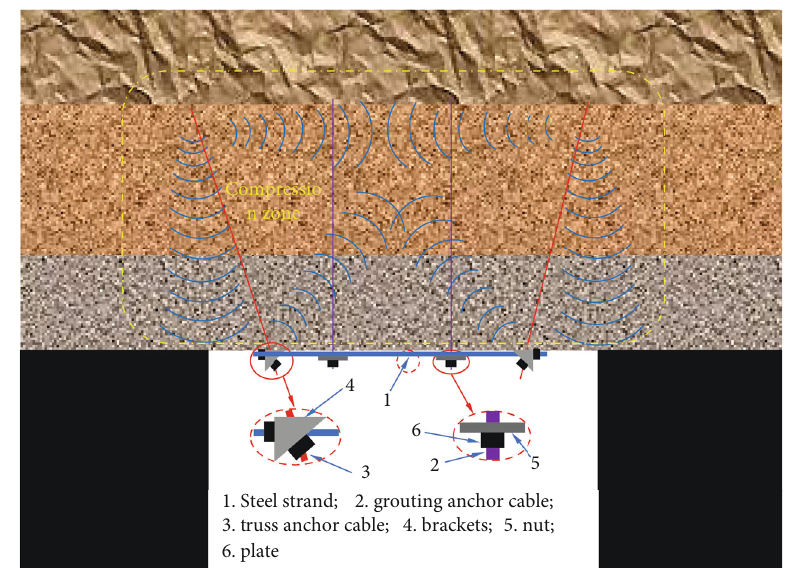
Figure 15: Schematic diagram of truss anchor cable support structure.